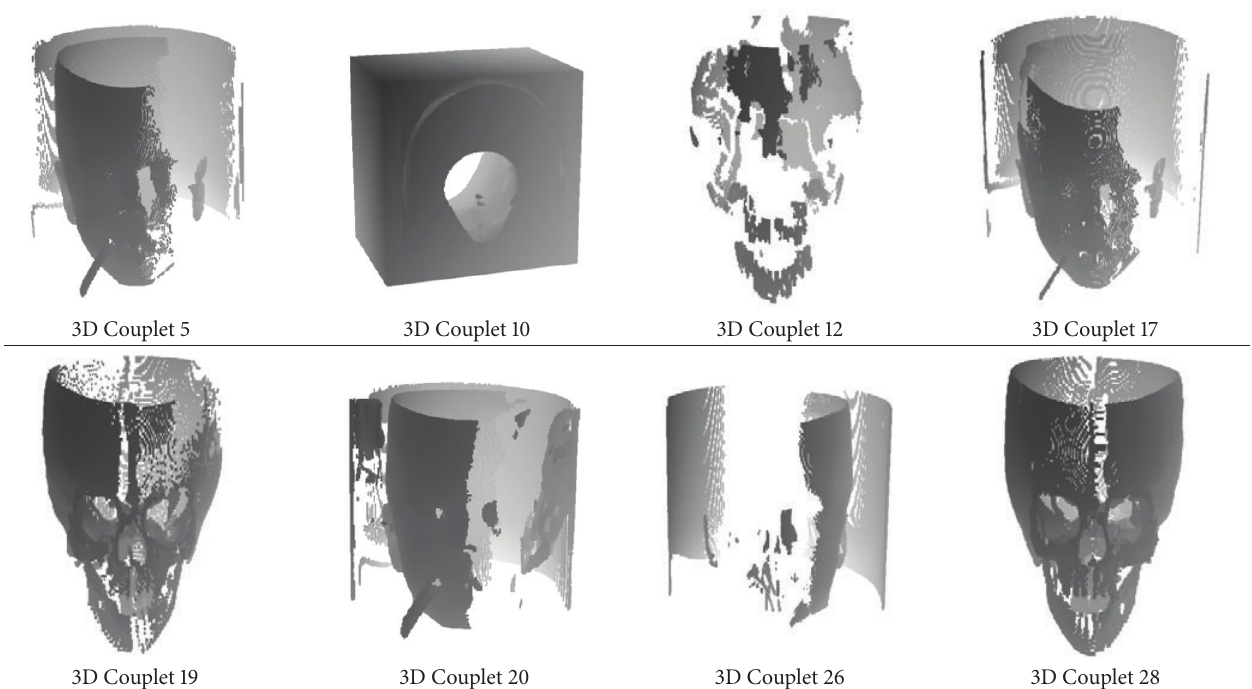
Table 13: Some 3D couplets, perpendicular to color axis, extracted from the 4D-EVM produced by means of Framework n D-EVM/Kohonen and associated to dataset VL-Baby